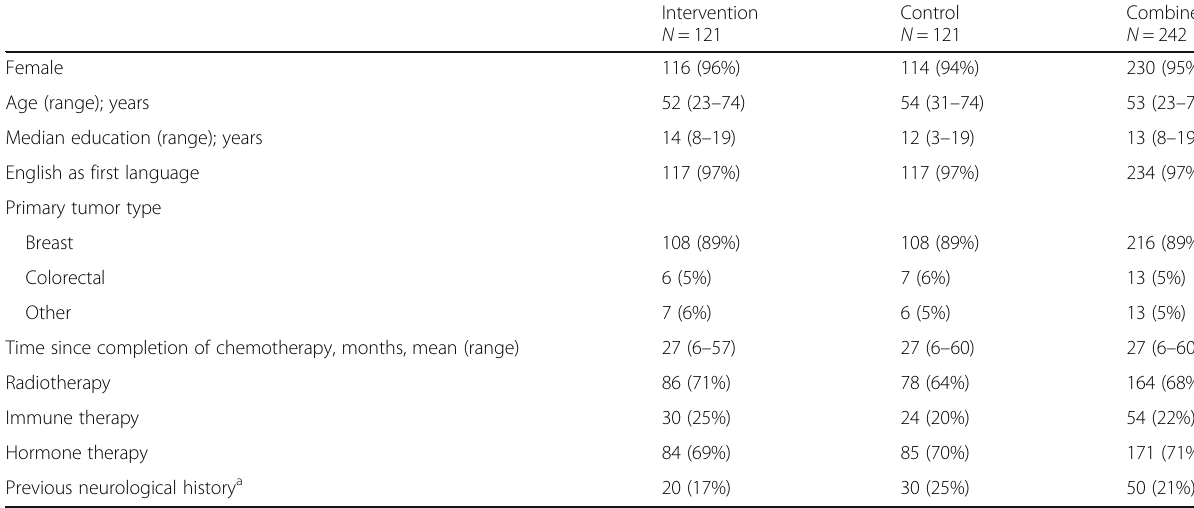
Table 1 Participant characteristics of a randomized controlled trial evaluating a web-based intervention for improving self-reported cognitive functioning in adult cancer survivors